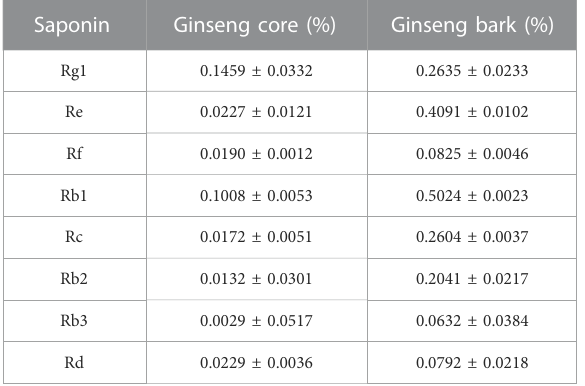
TABLE 1 Content of 8 saponin in ginseng core and ginseng bark (%) (x ± s, n = 6).